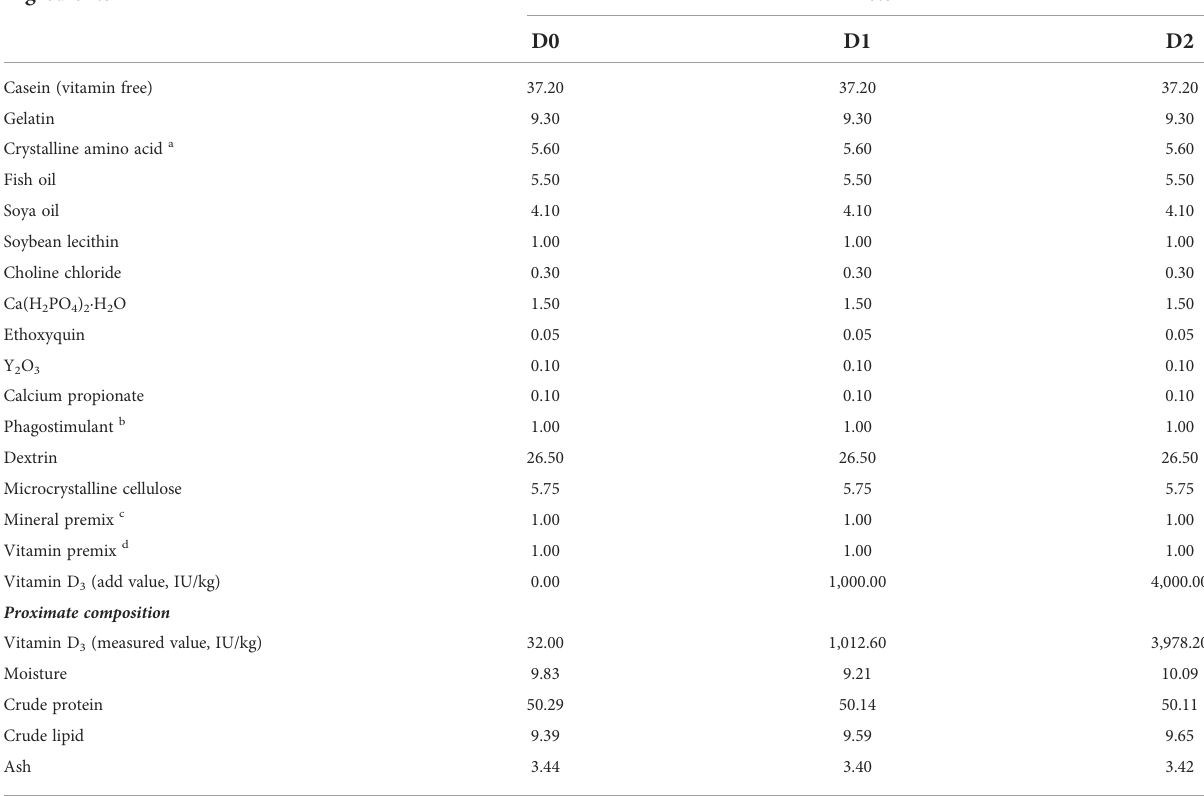
TABLE 1 Formulation and proximate composition of the experimental diets (% dry